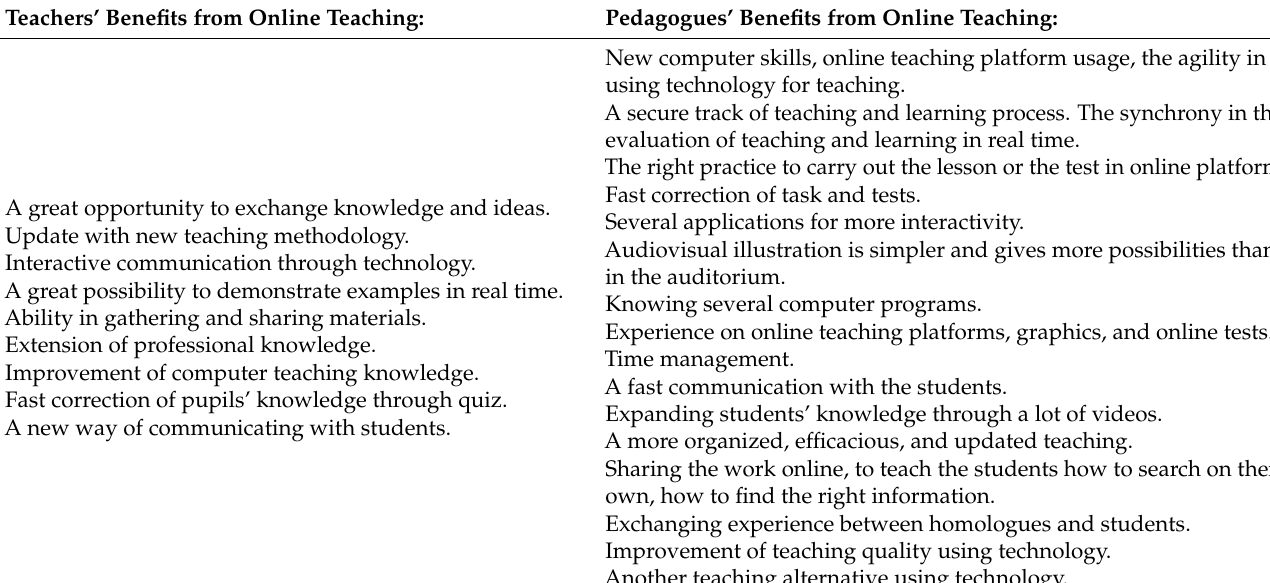
Table 8. Teachers and pedagogues benefit from online